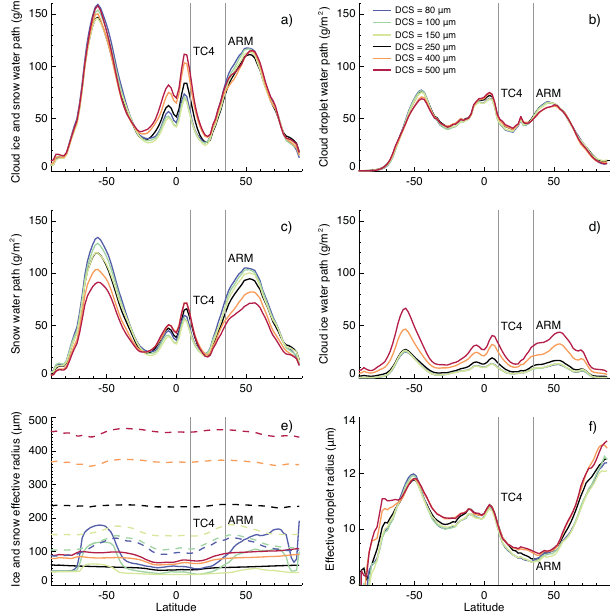
Figure 14. Zonal averaged cloud ice and snow water path (a) , cloud droplet water path (b) , snow water path (c) , cloud ice water path (d) , ice (solid) and snow (dashed) effective radius (e) and effective droplet radius (d) for the six different D cs simulations.